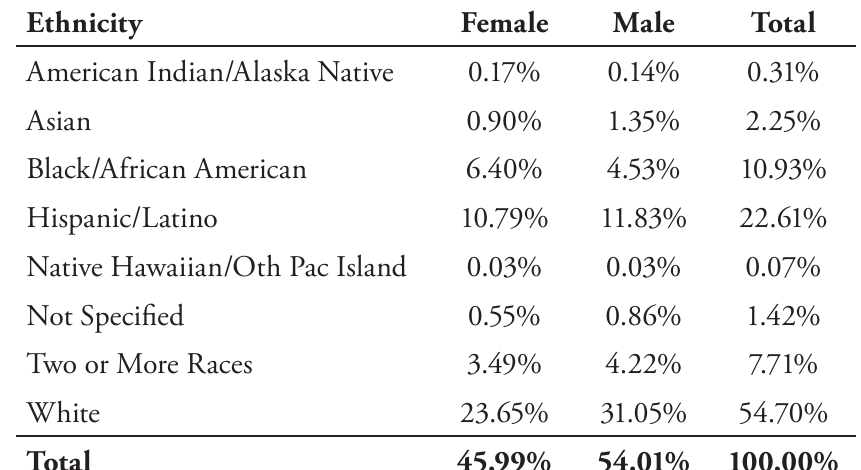
Table 1. Comprehensive Distribution of Students Identified